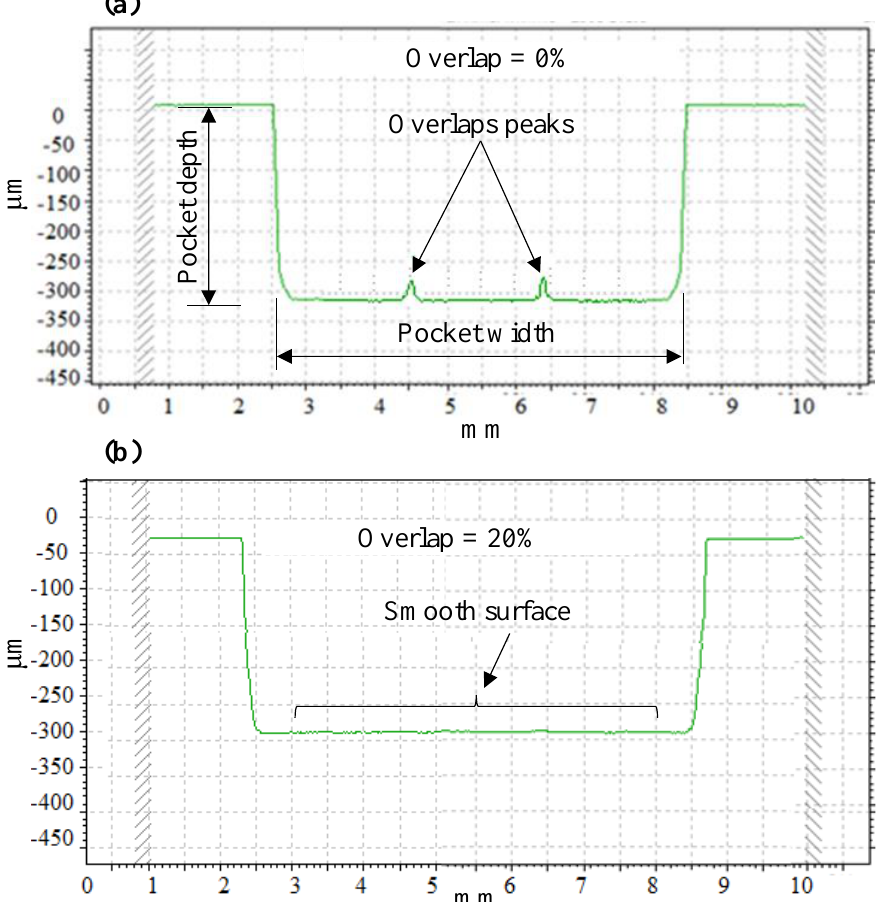
Figure 8. Typical example of the pocket’s profiles machined at ( a ) 0% tool overlapping and ( b ) 20% of the tool overlapping.